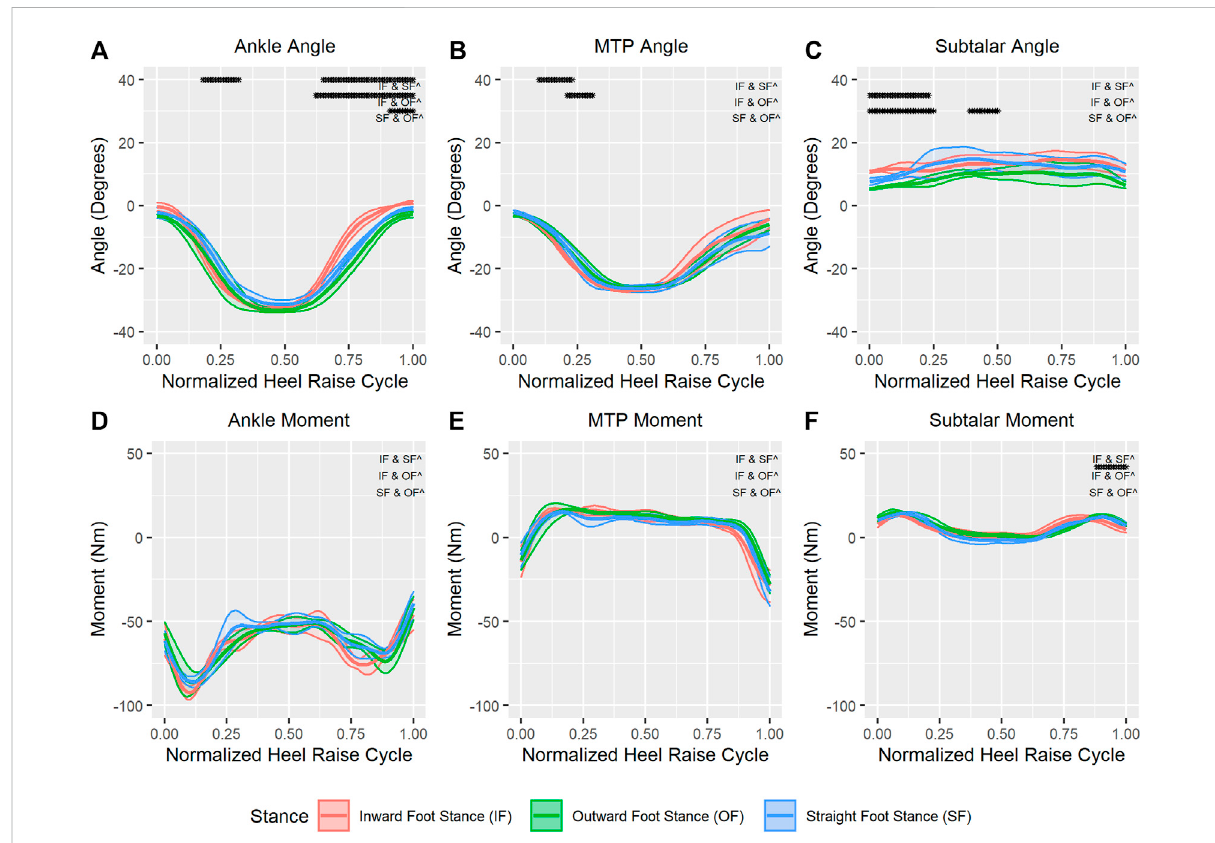
FIGURE 5 Average (±SD) ankle joint angle (A) and moment (D) , MTP joint angle (B) and moment (E) , and subtalar joint angle (C) and moment (F) for outward,inward,andstraightfootstancesthroughanormalizedheelraisecycle.Solidcenterlinesindicatemeans,andthesurroundingshadedareas indicate ±1 standard deviation. Asterisks indicate statistical signi fi cance ( α = 0.05) through a phase of a minimum of 10 consecutive statistically signi fi cant time normalized